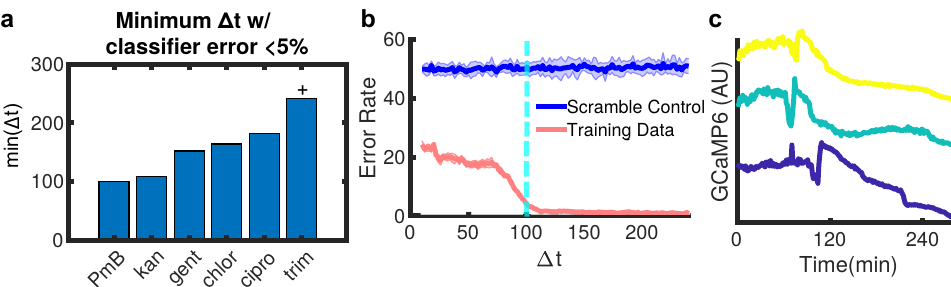
Figure 7. Ca 2 + dynamics distinguish sensitivity and resistance to other drug classes. ( a ) Comparing the minimum ∆ t to reach <5% error rates for 6 different antibiotics. Abbreviations are: PmB = Polymyxin B, kan = Kanamycin, gent = Gentamicin, chlor = Chloramphenicol, cipro = Ciprofloxacin, trim = Trimethoprim. See Figure S7, for error traces and full-time course classifier performance for all drugs. See Table S1 for concentrations tested as well as optimal hyper-parameters for each classifier. Plus-sign indicates that Trimethoprim never reaches <5% error threshold in 240 minute time-course. ( b ) Error rate as a function of ∆ t for Polymyxin B sensitivity classifier (red curves). The blue curve is the error rate of the same random forest architecture trained on scrambled cell labels. Error bars are the variance calculated between 10 and folds (80/20 split). Dashed, cyan line marks when the error rate is first below 5% at 100 min. ( c ) Example GCaMP6 signal in three single cells in response to 10 µ g/mL Polymyxin